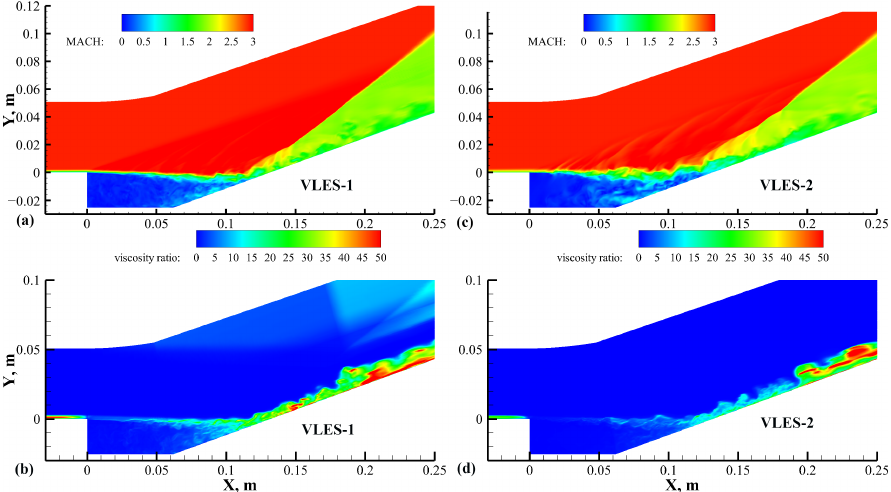
Figure 8. Contours of Mach number and viscosity ratio from the VLES results: ( a , b ) VLES-1, ( c , d )